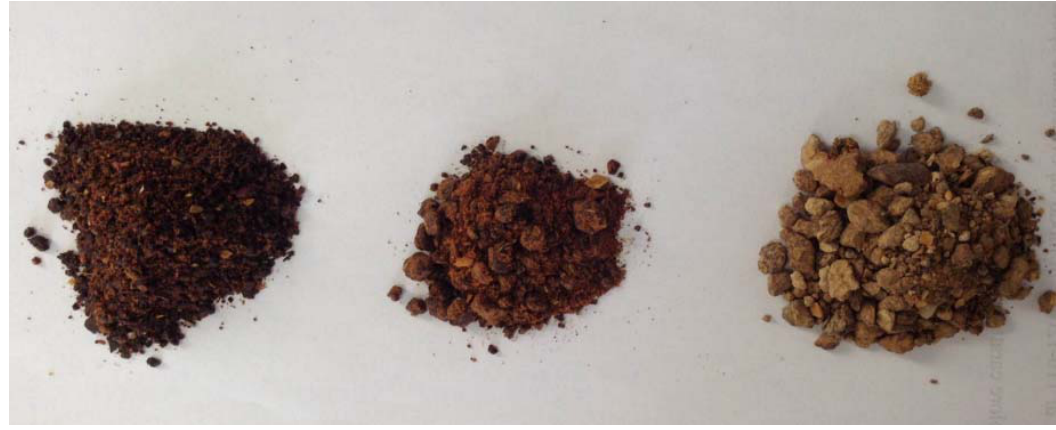
Figure 1. Samples of commercial neem cakes. NCE was obtained from the product in the